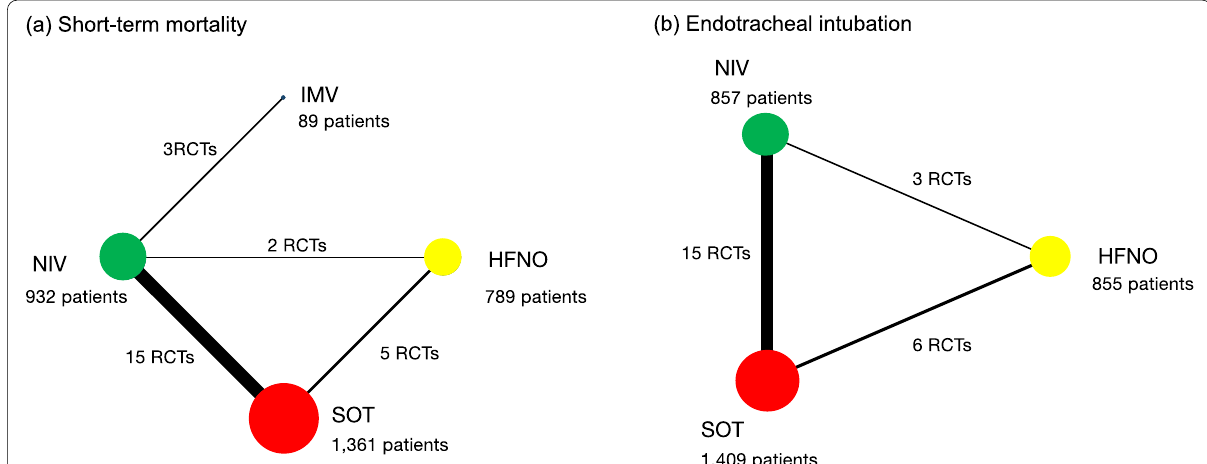
Fig. 2 Network plot of noninvasive oxygenation strategies for adults with AHRF. When RCTs for direct comparisons were available, they were shown by connections between the nodes. The size of the node represents the number of participants who received the intervention. The thickness of the lines connecting the nodes represents the number of trials for that comparison. Abbreviations: HFNO (high-flow nasal oxygen); IMV (invasive mechanical ventilation); NIV (noninvasive ventilation); RCT (randomized controlled trial); SOT (standard oxygen